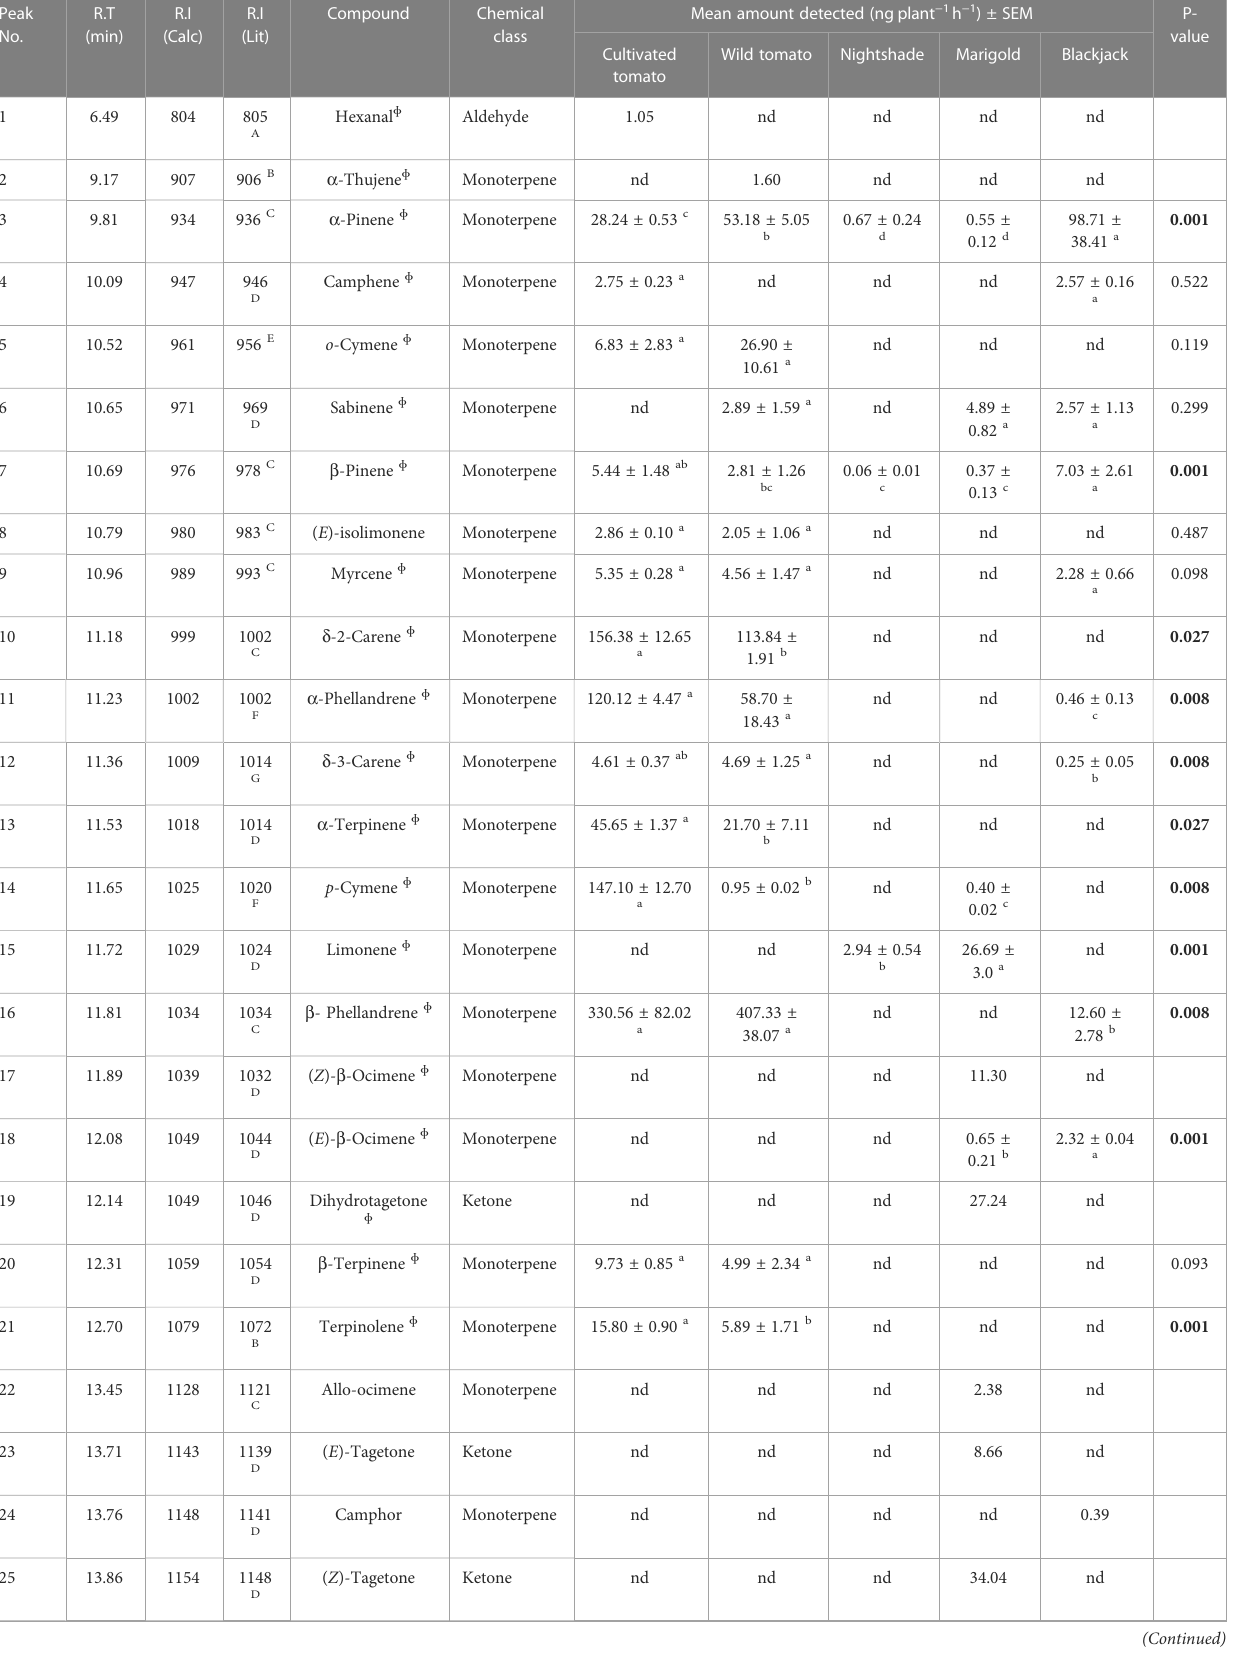
TABLE 2 Mean amount (ngplant − 1 h − 1 ) of the released volatiles in the headspace of host and non-host plants of Tuta absoluta . Peak